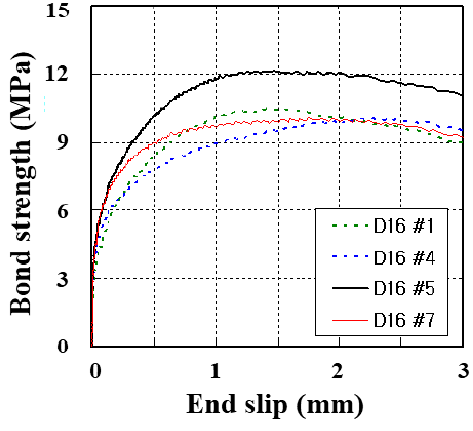
Figure 14. Bond strength–slip curves of GFRP rebars. Table 5. Test results of the pull-out test (D16 GFRP rebars, normal concrete).